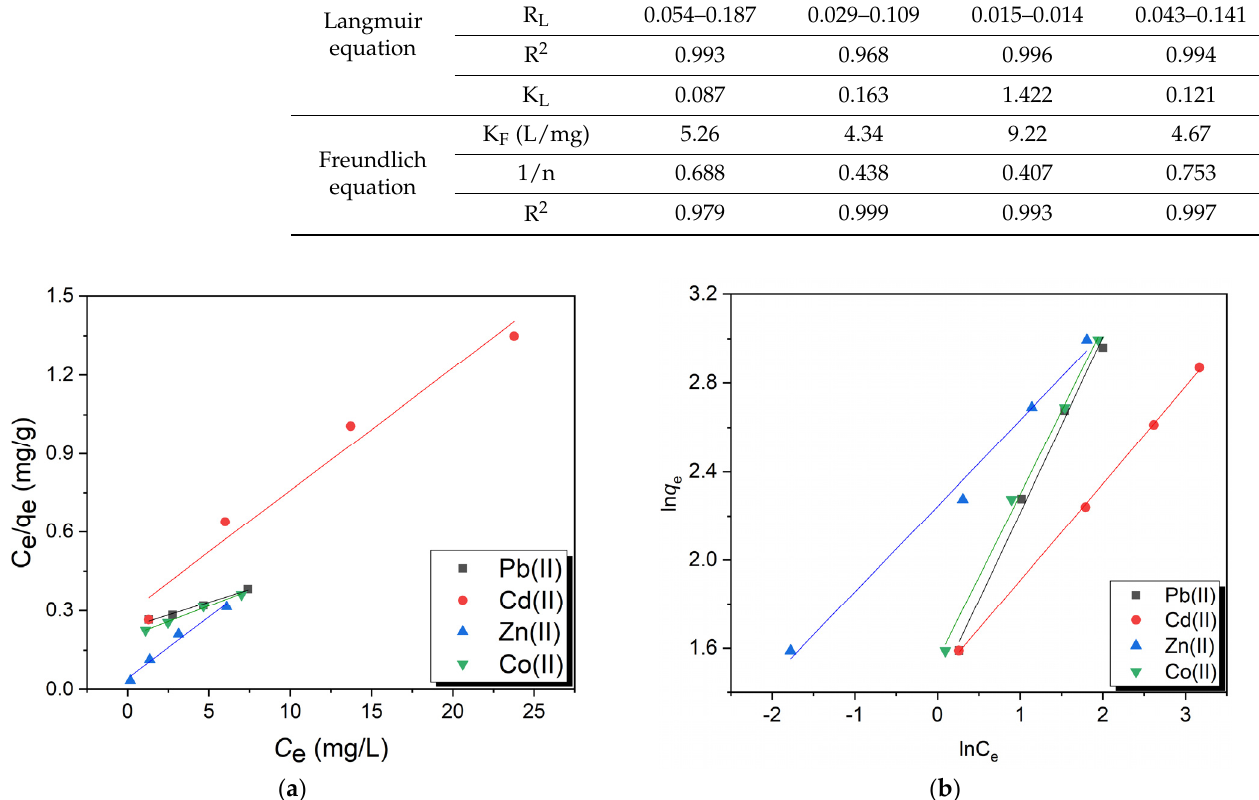
Figure 8. ( a ) Langmuir and ( b ) Freundlich adsorption isotherm models for the adsorption of Pb(II), Cd(II), Co(II), and Zn(II) onto PVA-CS/CE composite hydrogel beads. Table 1. Adsorption isotherm parameters of Pb(II), Cd(II), Zn(II), and Co(II) onto PVA-CS/CE.